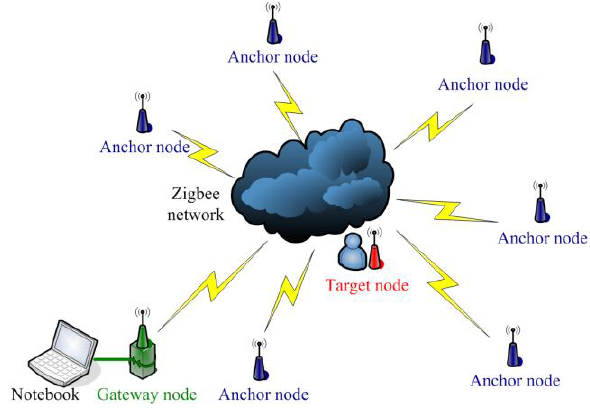
Figure 11. Illustration of the structure for the WSN localization system.